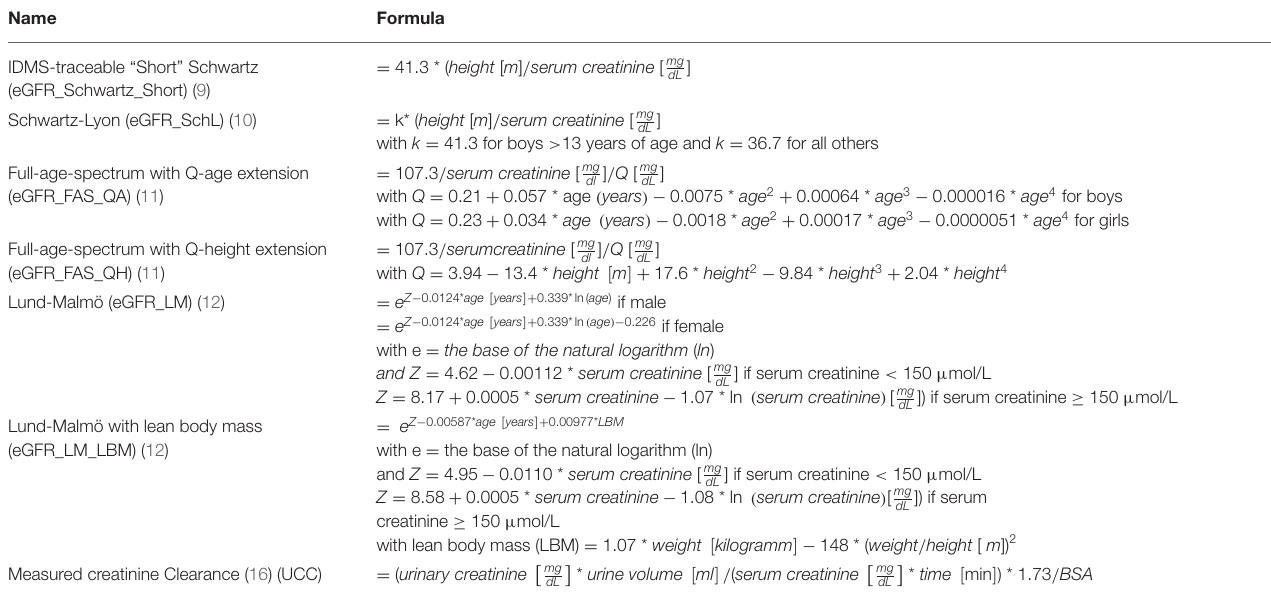
TABLE 1 | eGFR formulae used in this